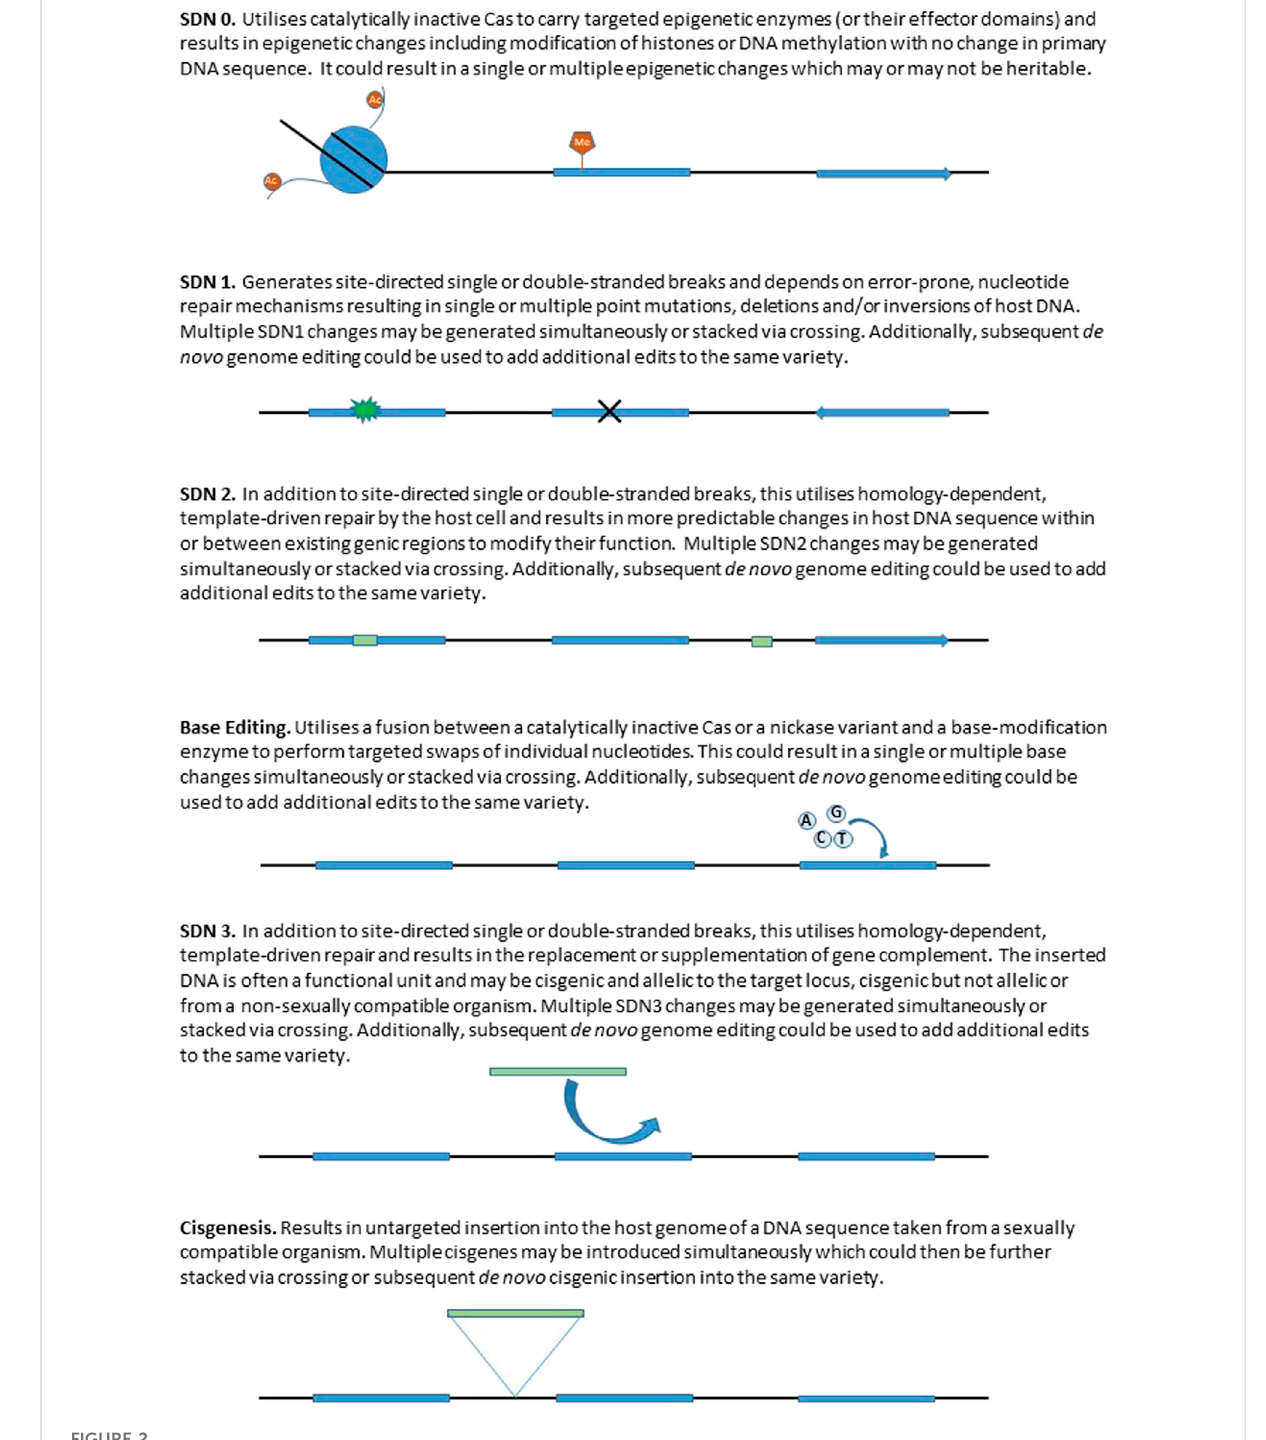
Frontiers in Genome